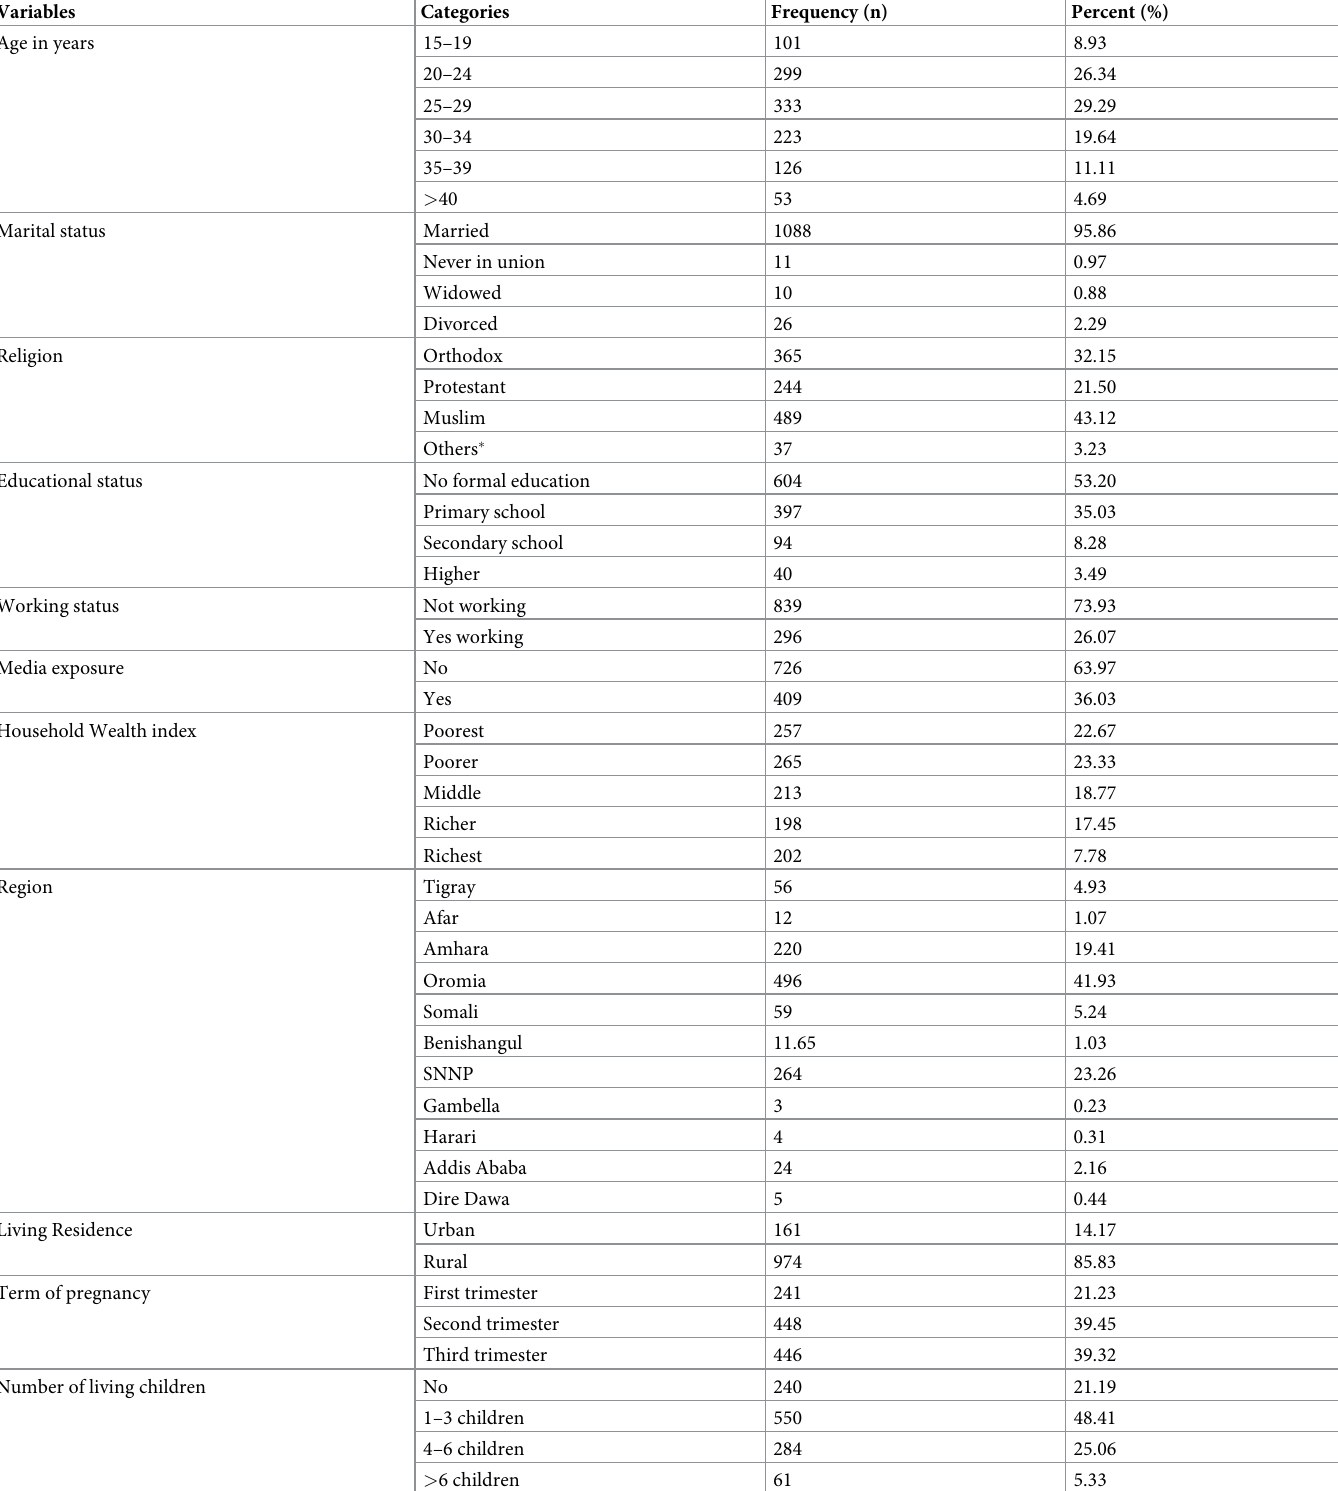
Table 1. Socio-demographic, pregnancy and behavioral characteristics of pregnant women according to EDHS of 2016 (n =